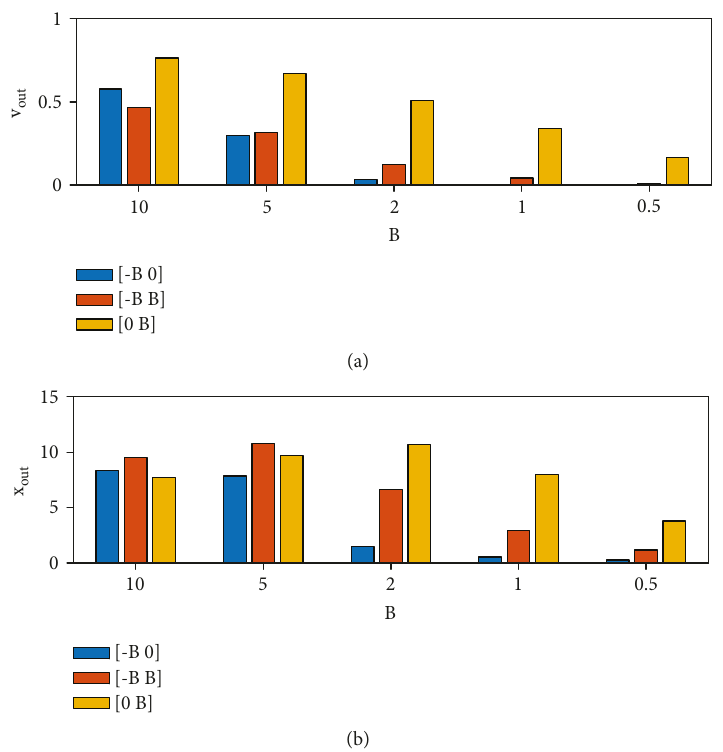
Figure 3: The per cent of new individuals with (a) location and (b) velocity, outside the permitted area for the Griewank function.